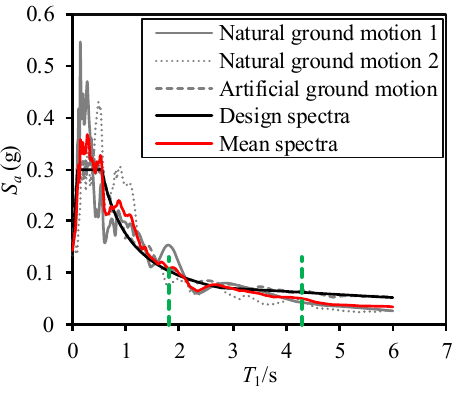
Figure 15. Response spectra of the selected ground motions. Table 5. Critical design parameters and indexes of the isolated tall building.